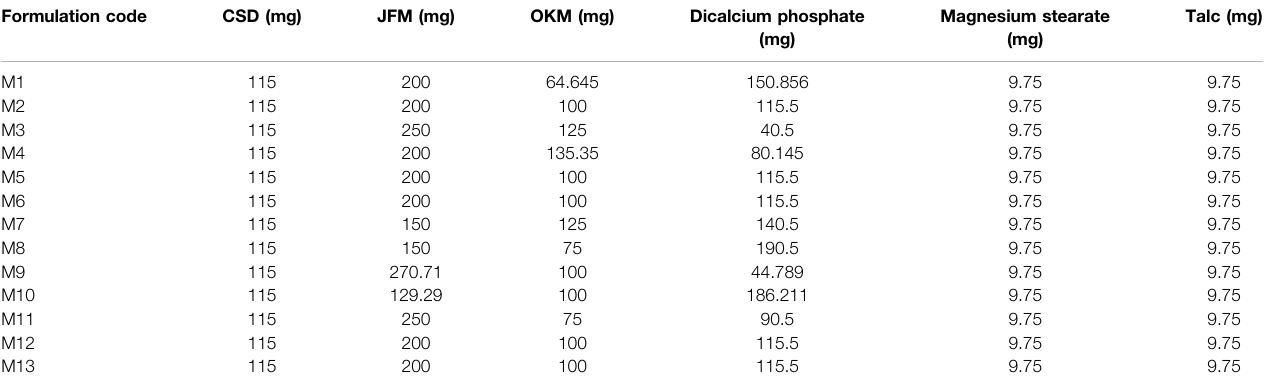
TABLE 1 | Composition of various CMN mucoadhesive tablet formulations. Formulation